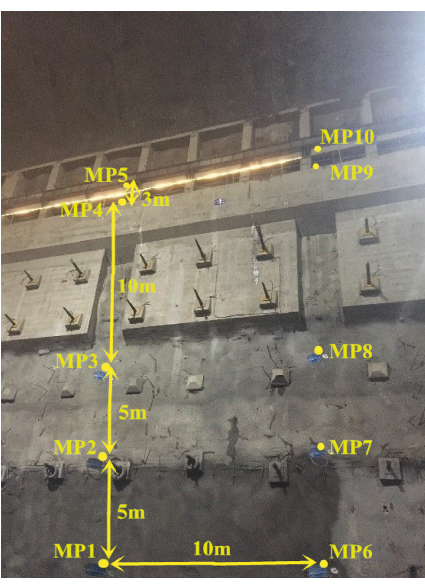
Figure 2: Instrument layout for the blasting vibration test of high side wall of the